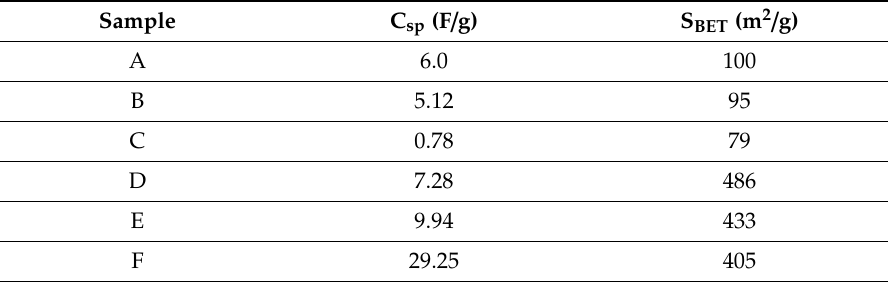
Table 6. C sp for Di ff erent Samples and their Corresponding S